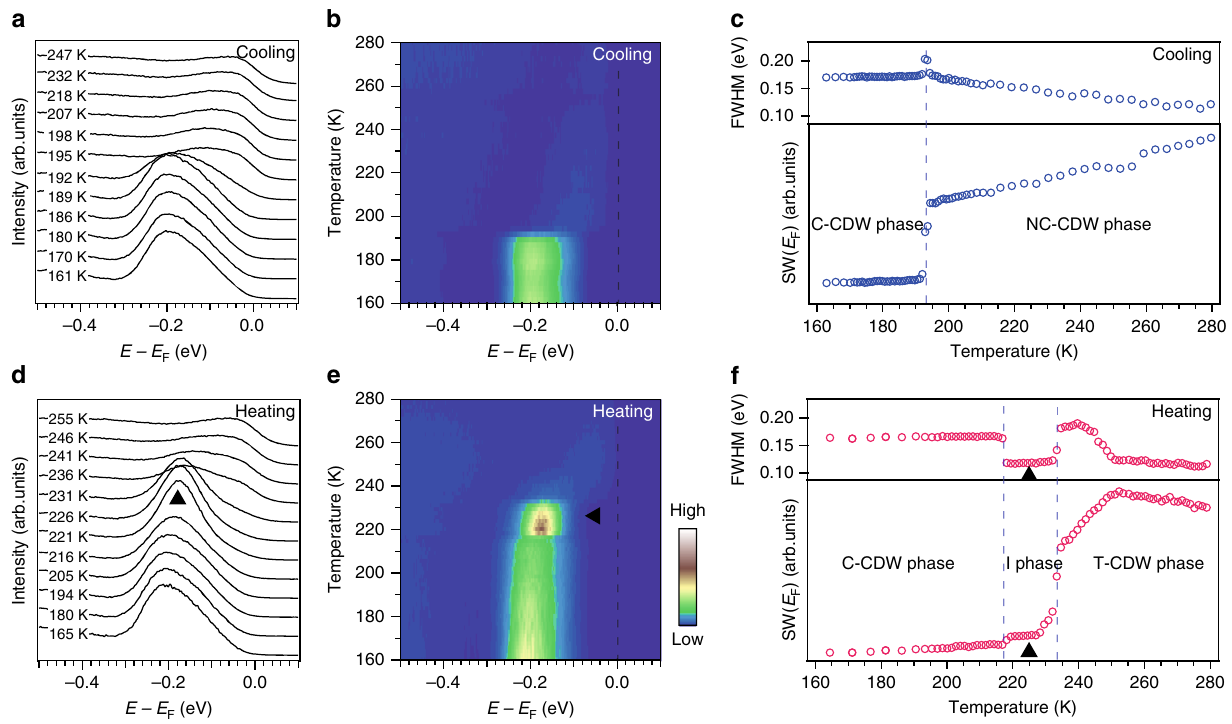
Fig. 2 Temperature-dependent ARPES study of 1 T -TaS 2 upon cooling and heating. a Temperature dependence of energy distribution curves (EDCs) taken at the Γ point upon cooling. b The merged image of the data in a . c Corresponding temperature dependence of full width at half maximum (FWHM) for the data in a , and the spectral weight (SW) taken at where the Ta 5 d band crosses E F ([ − 0.1, 0.1 eV], [ − 0.4, − 0.3 Å − 1 ]). d – f are the same as a – c but for the heating process. Black arrows mark the intermediate (I)